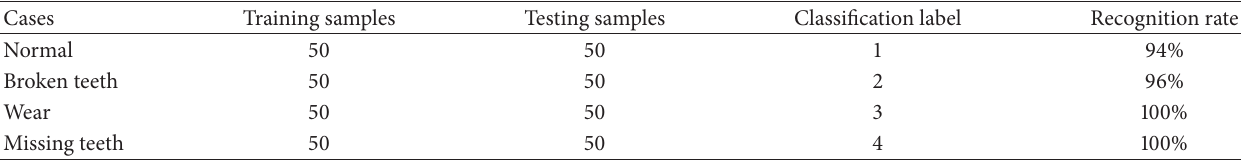
Table 6: Gear recognition